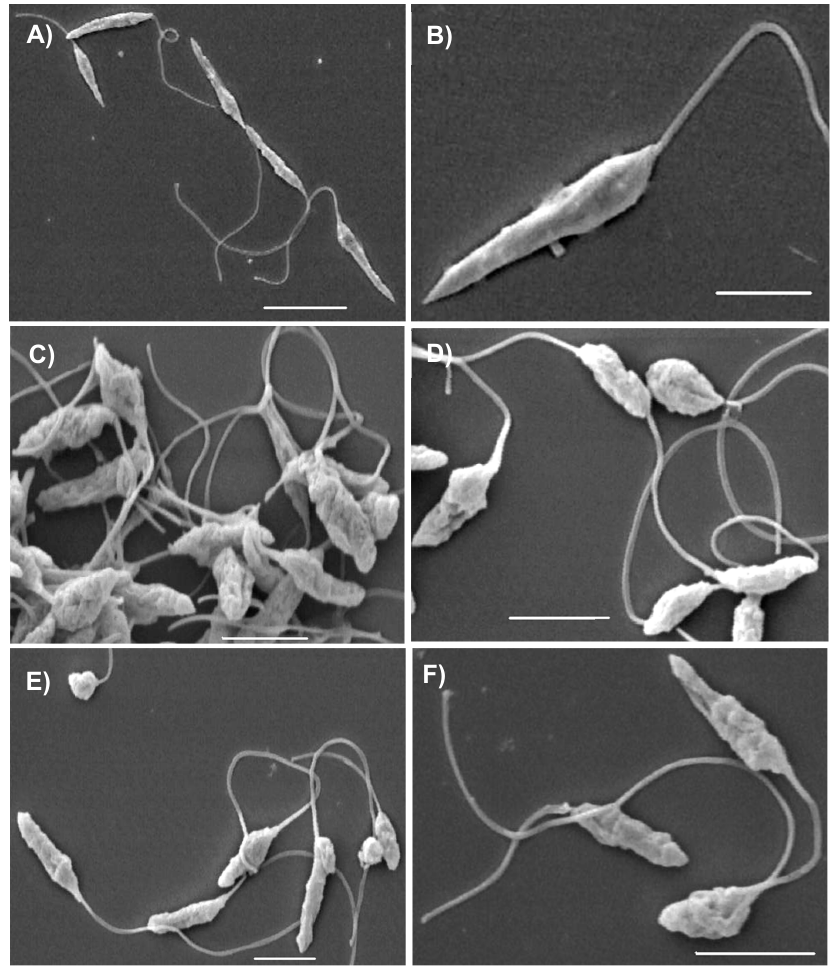
Figure 1. Scanning electron micrographs of Leishmania infantum promastigotes exposed to Lavandula luisieri essential oil. ( A , B ) Untreated cells showing the typical elongated shape, parasite body and anterior flagella; ( C – F ), Treated promastigotes. Note round forms and aberrant forms ( C – F ) with cell body septation ( D ). Note the irregular surface. ( A – F ) Bars = 5 µm.